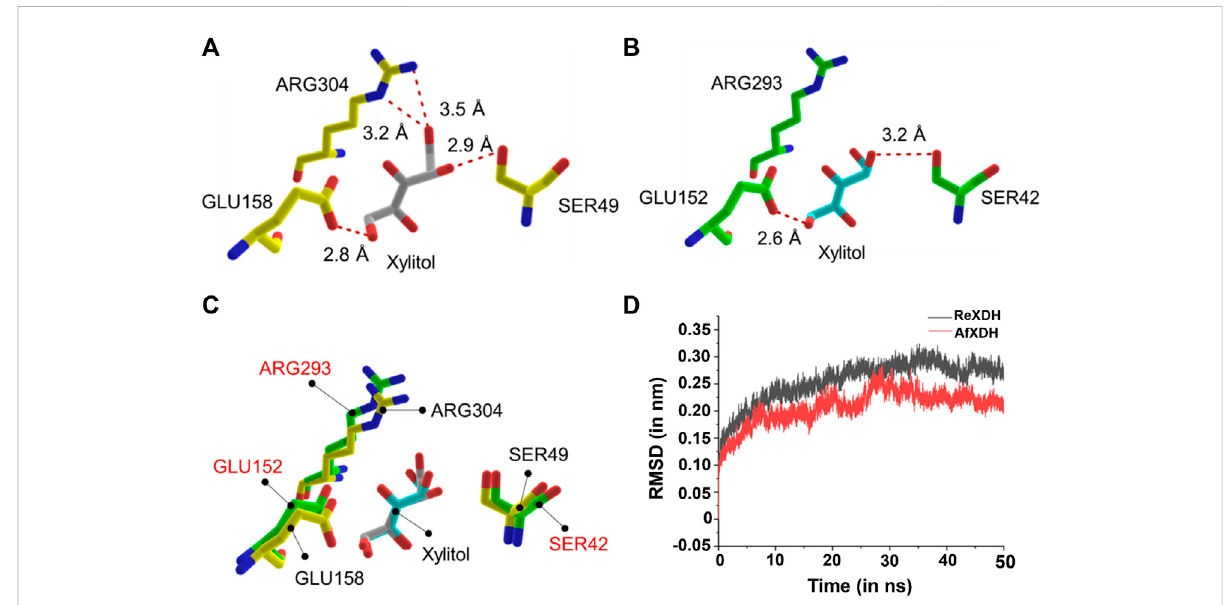
FIGURE 5 The docked complex of (A) AfXDH and (B) ReXDH with xylitol bound as substrate. The red dashed lines represent hydrogen bonds with donor- acceptor atom pair distance (in Å). Yellow stick model for AfXDH and green stick for ReXDH complex. (C) The superimposed active site residues of AfXDH (black label) and ReXDH (red label). (D) RMSD (in nm) analysis of AfXDH (red line) and ReXDH (black line) for 50 ns MD